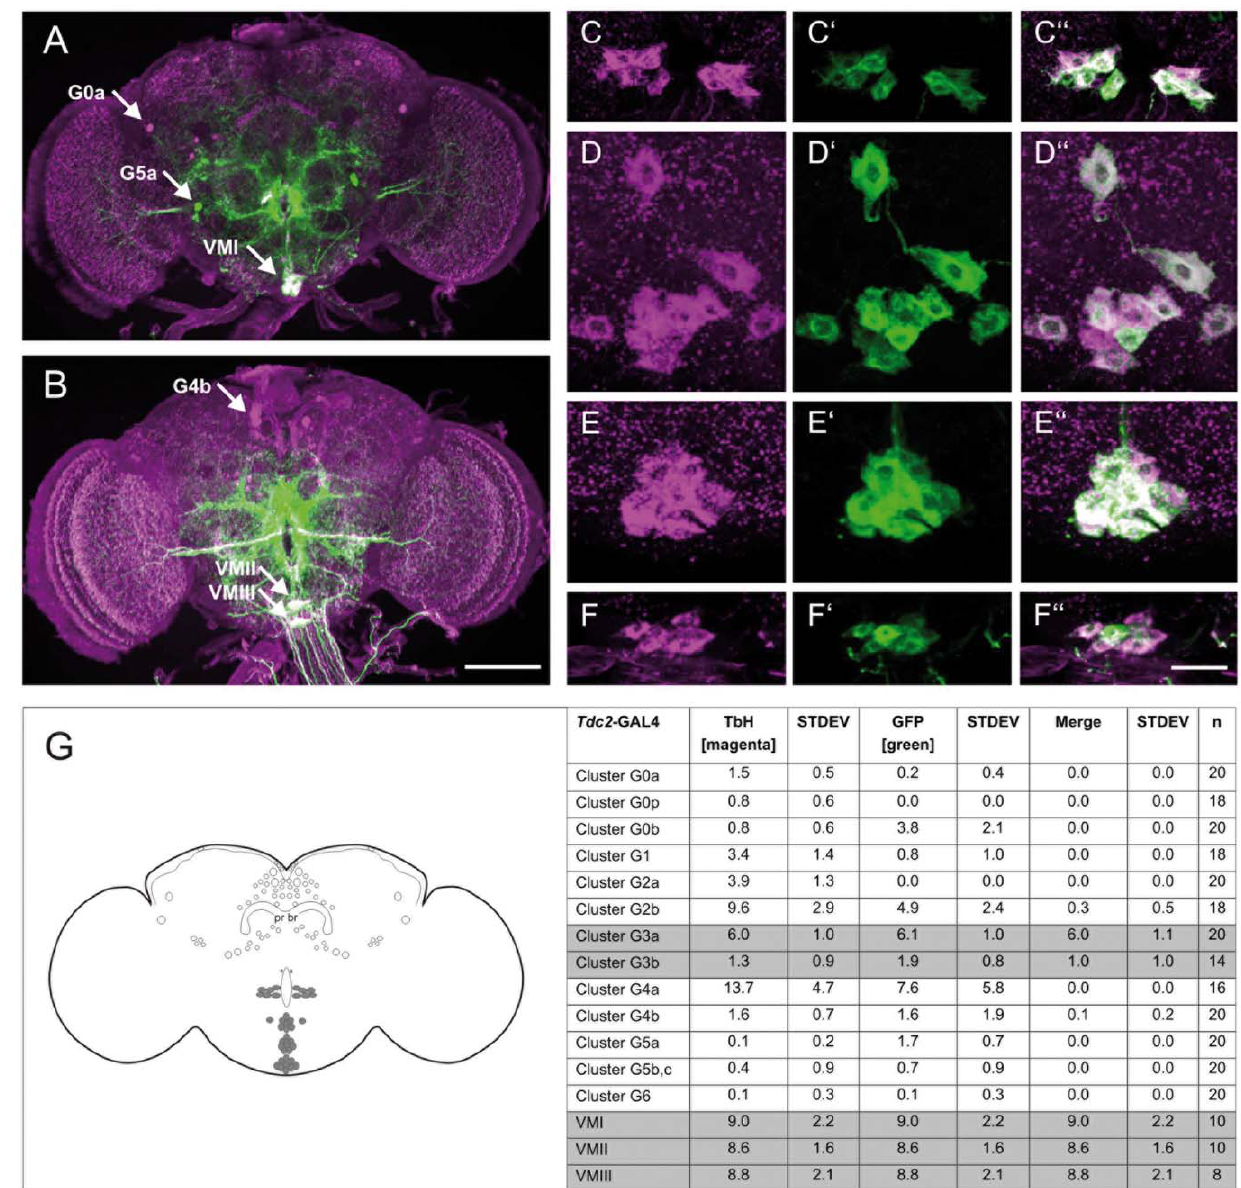
Figure 3. The Tdc2 -GAL4 activates UAS transgenes in a subset of TbH positive neurons. The GAL4 expression domain of the Tdc2 -GAL4line is visualized by GFP in comparison to TbH expression in the anterior ( a ) and posterior ( b ) part of the adult brain. Neurons expressing TbH (G0a) or GFP (G5a) and neurons expressing both (VMI) are highlighted with an arrow ( a ). In the back of the brain G4a neurons only express TbH, whereas VMII and VMIII neurons express both ( b ). The expression of Tbh ( c to f ) and GFP ( c 9 to f 9 ) is found in the same set of neurons of the G3a/AL2 cluster ( c 99 ), VMI ( d 99 ), VMII ( e 99 ) and VMIII ( f 9 ). The analysis of expression patterns is summarized in table g and clusters in which GFP and Tbh co-localize are highlighted in grey. The scale bar represents 25 m